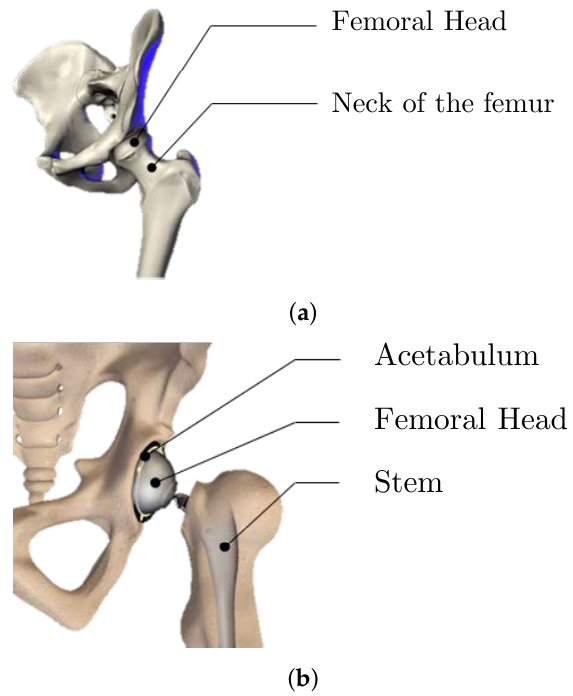
Figure 1. Pelvic bone ( a ) before and ( b ) after total hip